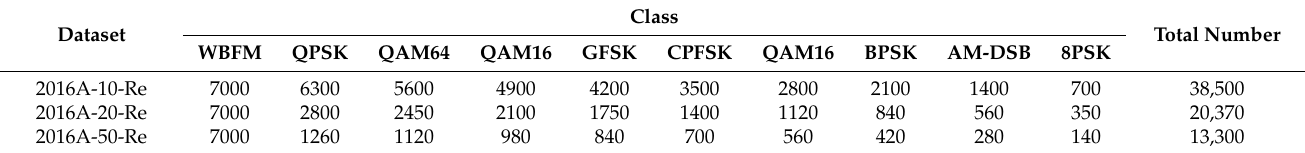
Table A2. Number of samples per class in the datasets created by reversing the original class list.